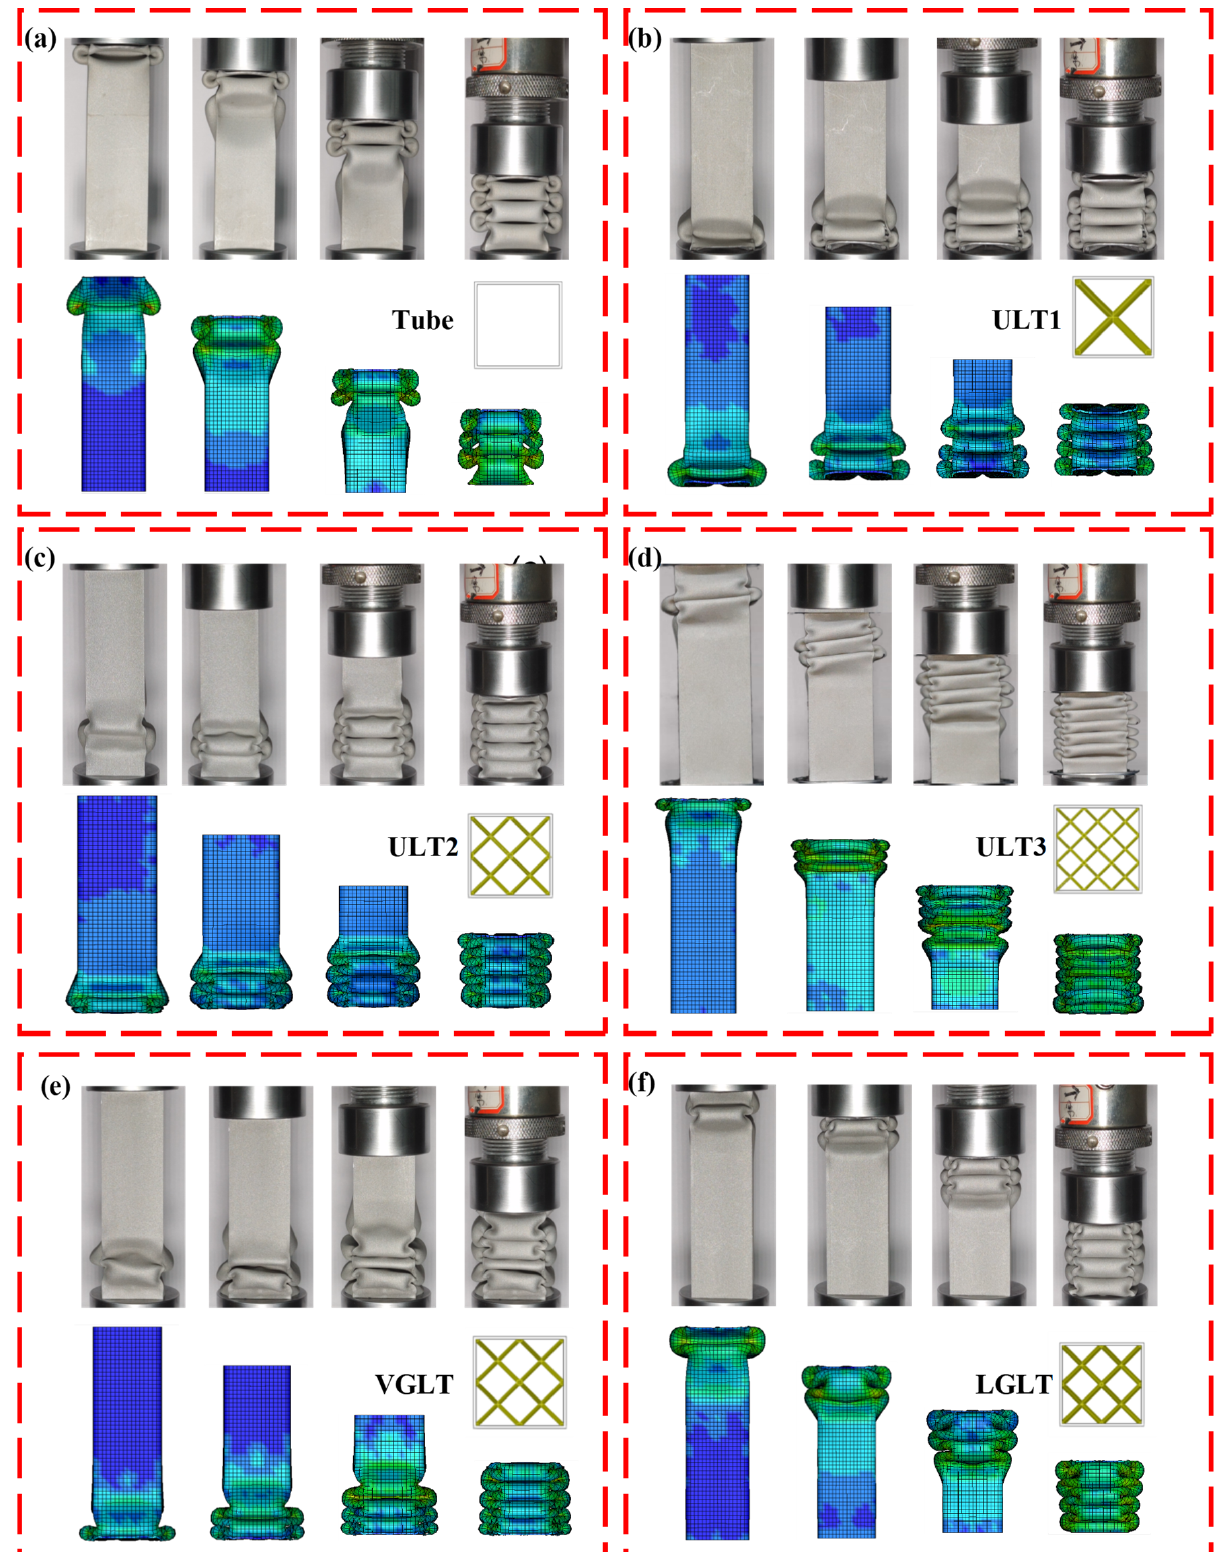
Figure 9. Deformation process of specimen experiment and simulation: ( a ) ULT1, ( b ) ULT1, ( c ) ULT2, ( d ) ULT3, ( e ) VGLT, ( f ) LGLT. ( d ) ULT3, ( e ) VGLT, ( f )